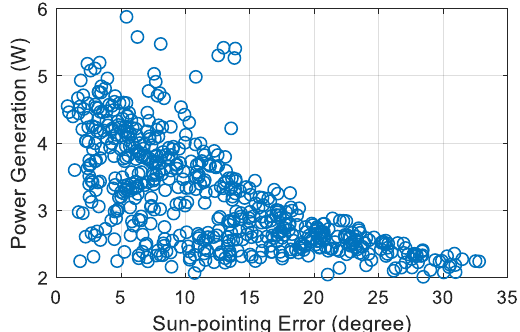
Figure 10. Correlation between sun-pointing error and power generation.